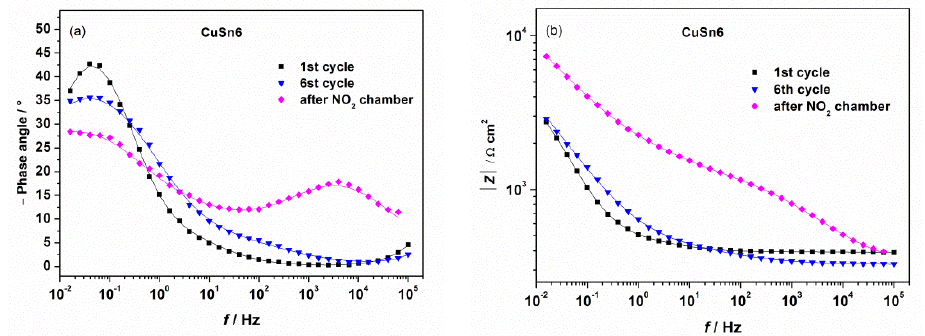
Figure 10. EIS spectra for CuSn6 bronze for continuous immersion in artificial urban rain at pH 6.5. ( a ) Bode phase angle; ( b ) Bode impedance. Table 9. EIS data for CuSn6 for alternating wet/dry cycles in simulated acid rain pH at 6.5 and after NO 2 chamber.